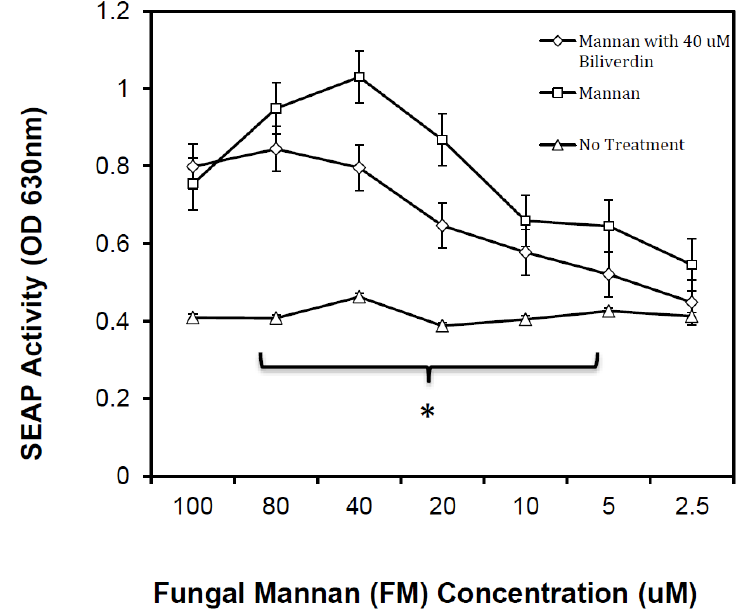
Figure 7. SEAP activity in culture supernatants derived from fungal mannan (FM)-treated HEK-Blue hTLR4 cells. Cells were plated at a cell density of 1 x 10 5 cells/well and incubated overnight with dilutions of FM (Squares), dilutions of FM plus 40 µ M Bv (Diamonds), or culture medium alone (Triangles). All FM and Bv dilutions were made in complete medium with FCS. The